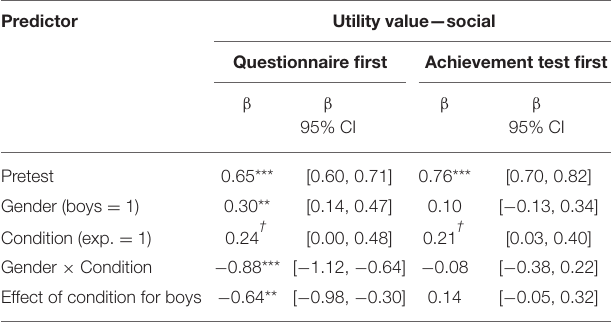
TABLE 7 | Multiple-group multiple regression model: effects on social utility value.